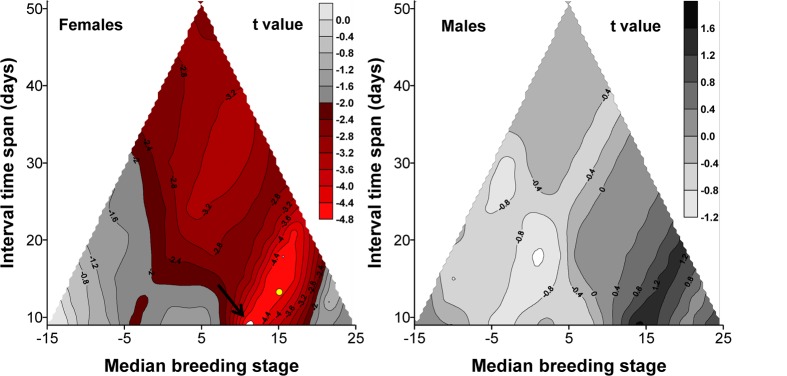
Strength of the association between growing R4 length and clutch size during the breeding cycle.Contouring of t-values associated to the effect of clutch size on LengthRe (see Methods) of females obtained in multiple regression models also including breeding stage and date at original feather removal (see Table 5). t-values were obtained from models including ranges of breeding stages centered at different median values and differing in width (see SI.5). Thus, for example, the yellow dot indicates a model where breeding stages spanning from breeding stage 10 and 21, and centered on breeding stage 15.5 were considered. Red isopletes indicate breeding stage ranges where unsigned t-values were significant. The arrow indicates the range where the unsigned t-value was largest. The apex of the triangle denotes the t-value of the models including the entire range of breeding stages (i.e. all data points) (see Table 5).